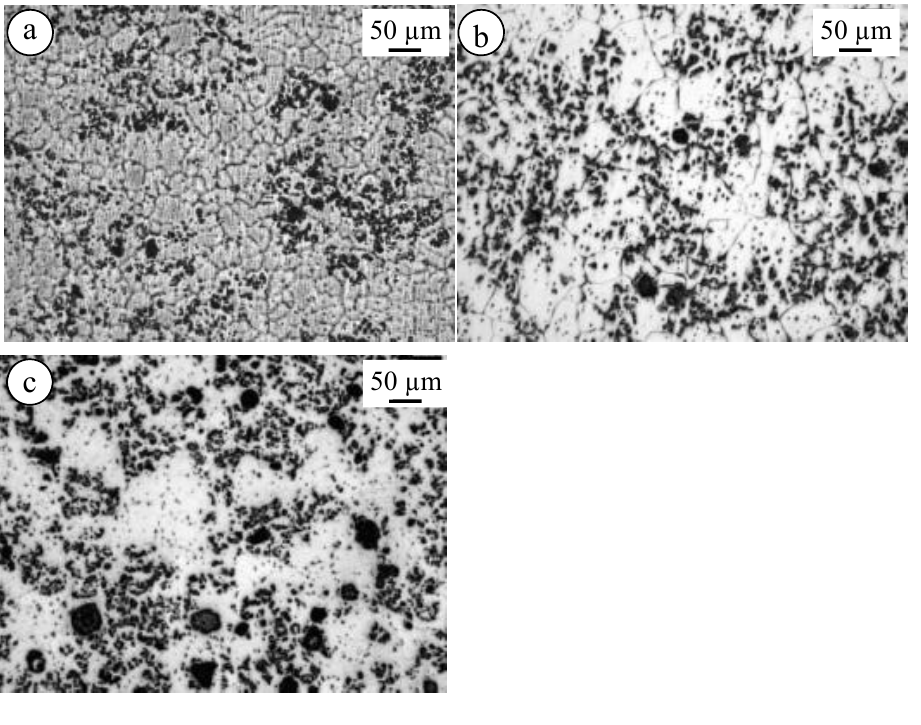
Figure 15. Microstructure of El21–2.0 wt.% AlN: ( a ) as ‐ cast; ( b ) solutionized at 520 °C; and ( c ) solutionized at 550 °C.